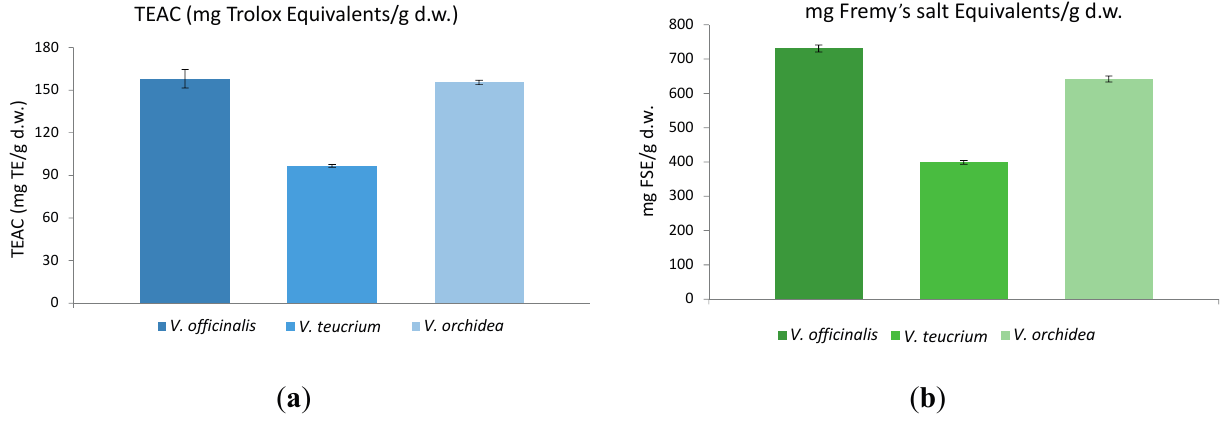
Figure 4. ( a ) Trolox equivelents antioxidant capacity (TEAC) and ( b ) antioxidant activity measured with EPR spectroscopy using Fremy’s salt as a stable synthetic radical of Veronica species (the bars indicate mean ± SD).